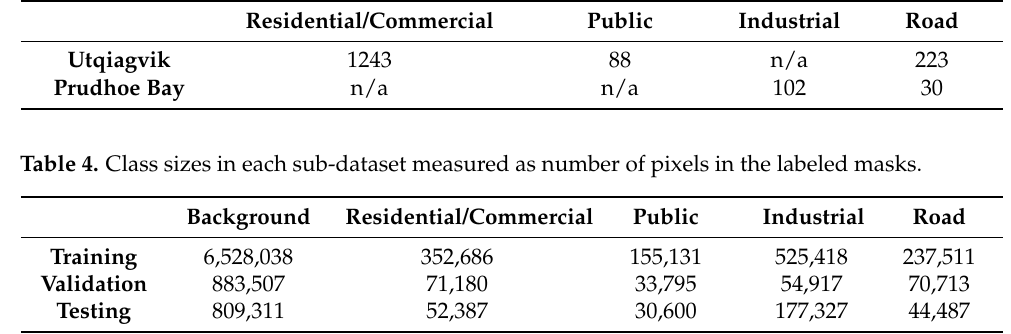
Table 3. Number of features (individual structures) belonging to each infrastructure type in the dataset.